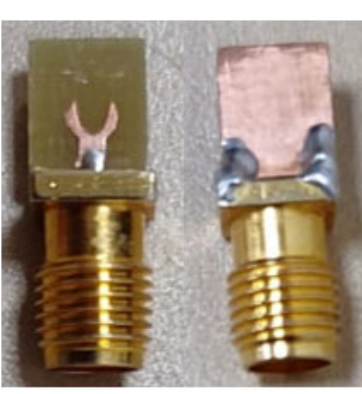
Figure 2. The prototype of the projected antenna design depicts the front and ground plane.